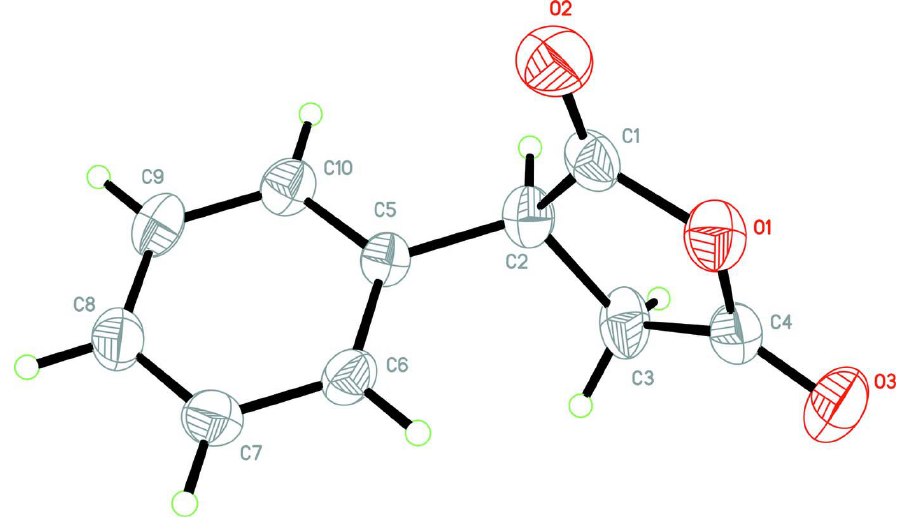
The molecular structure of the title compound, showing displacement ellipsoids drawn at the 30% probability